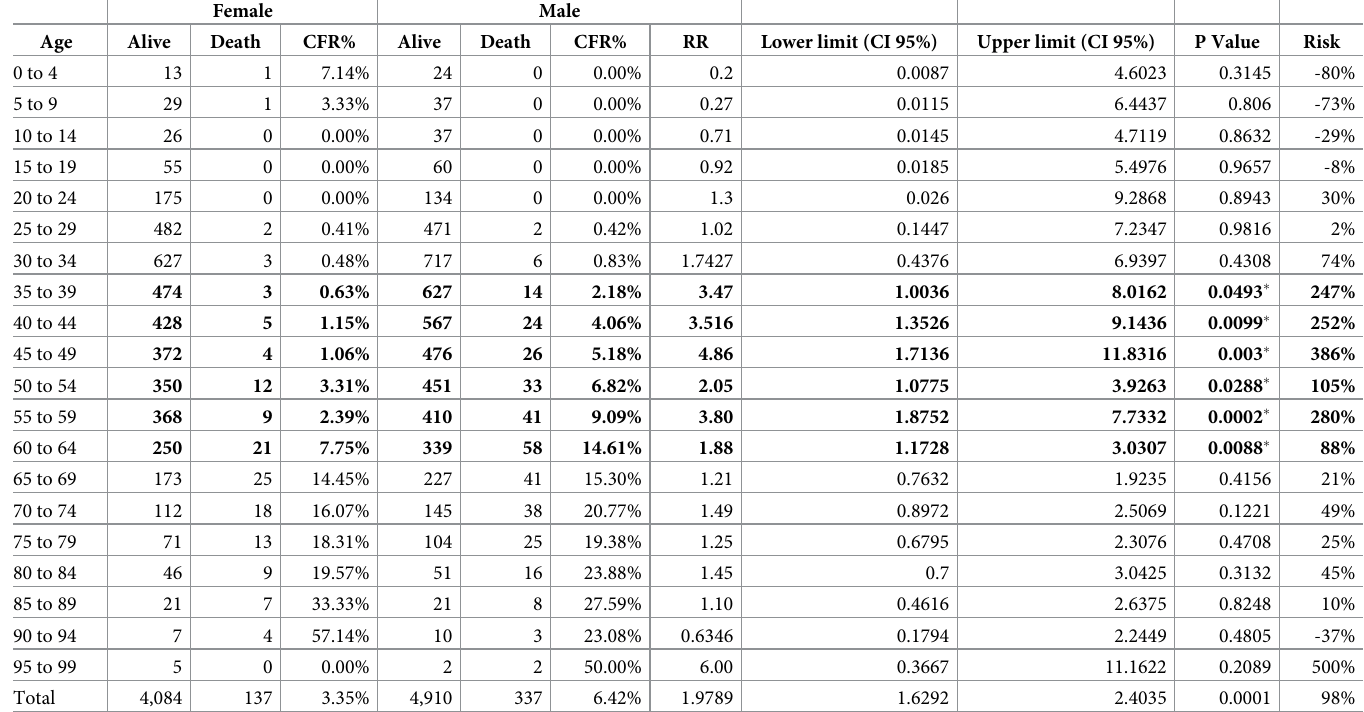
Table 1. Case fatality rate (CFR%) due to COVID-19 and relative risk (RR) in Ecuador among women and men from different age groups (N = 9,468). � P-values below or equal to 0.05 were considered